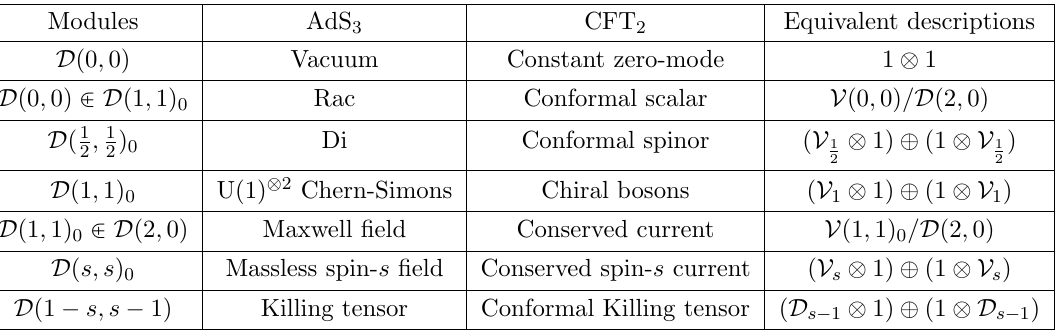
Table 1 . List of relevant so (2 ; 2) modules and their (cid:12)eld-theoretical